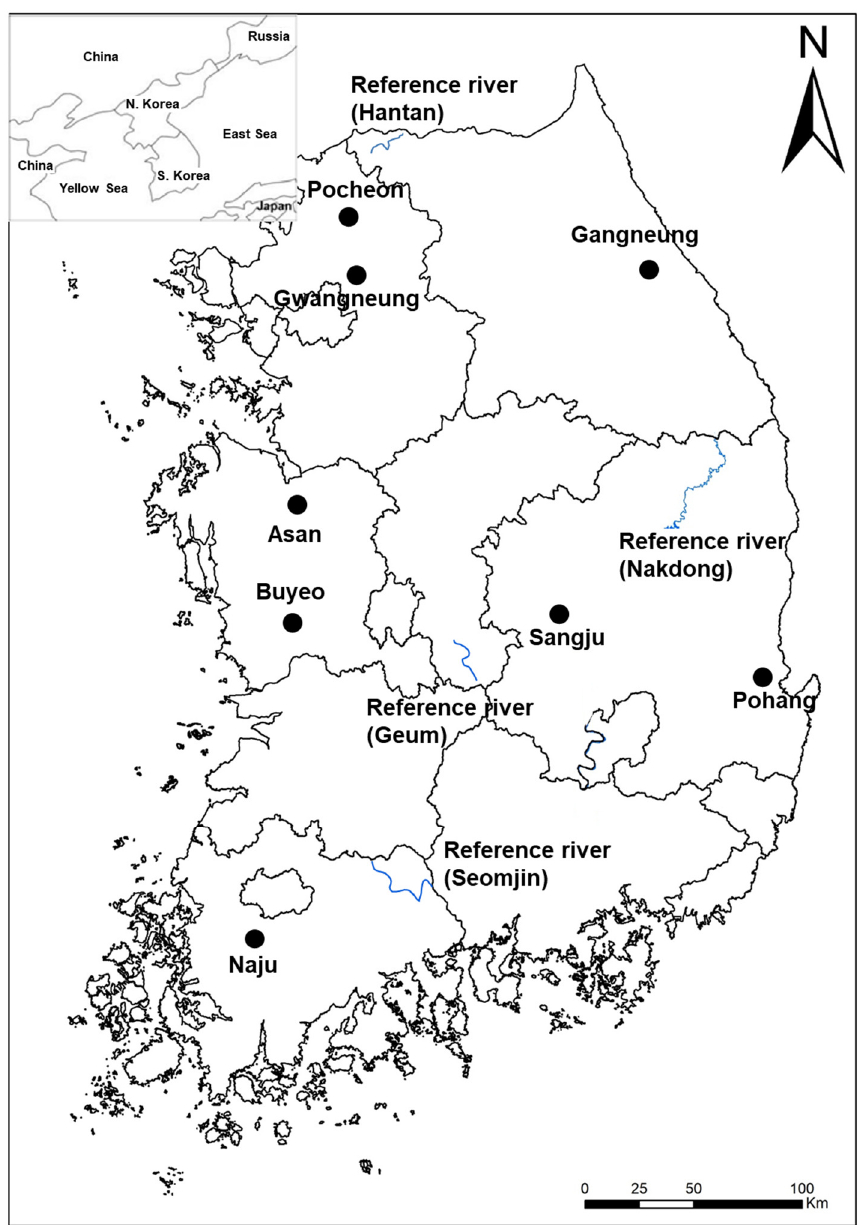
Naju, Gangneung, Sangju, and Pohang were selected as survey sites in the northwest, west- central, southwest, northeast, east-central, and southeast regions, respectively.